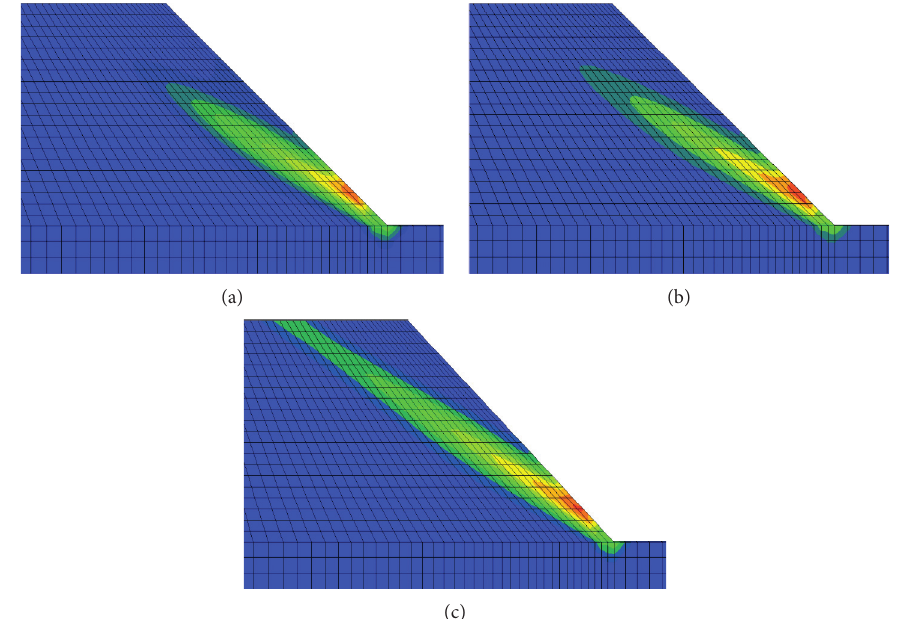
Figure 4: Varying failure mechanism during a SRM with dilation ψ � 20 ° , (a) SRF � 1.10, (b) SRF � 1.20, (c) SRF � 1.26.